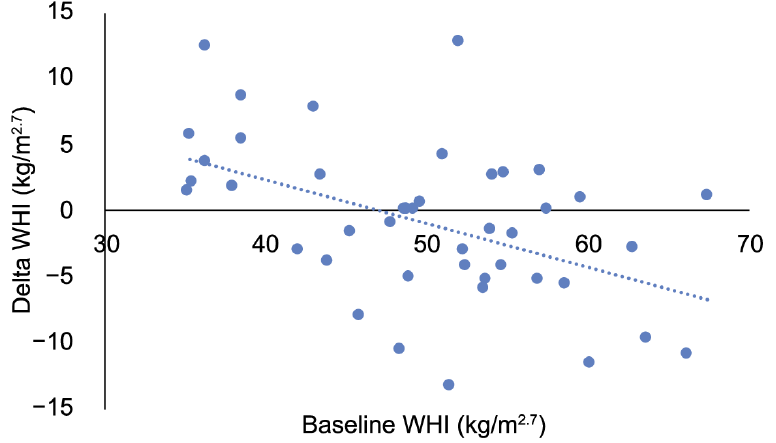
Figure 2. Delta weight-for-height index (WHI) plotted against the baseline WHI in adult female long-tailed macaques that were subjected to a minor dietary change.